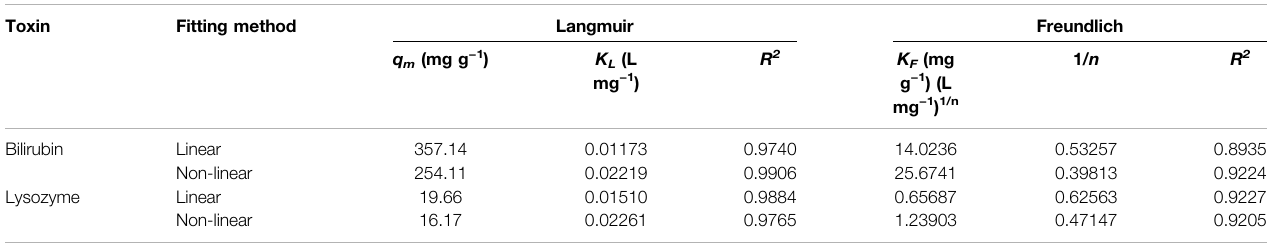
TABLE 2 | Adsorption isotherm parameters of HCP(St-DVB-VP) towards bilirubin and lysozyme. Toxin Fitting